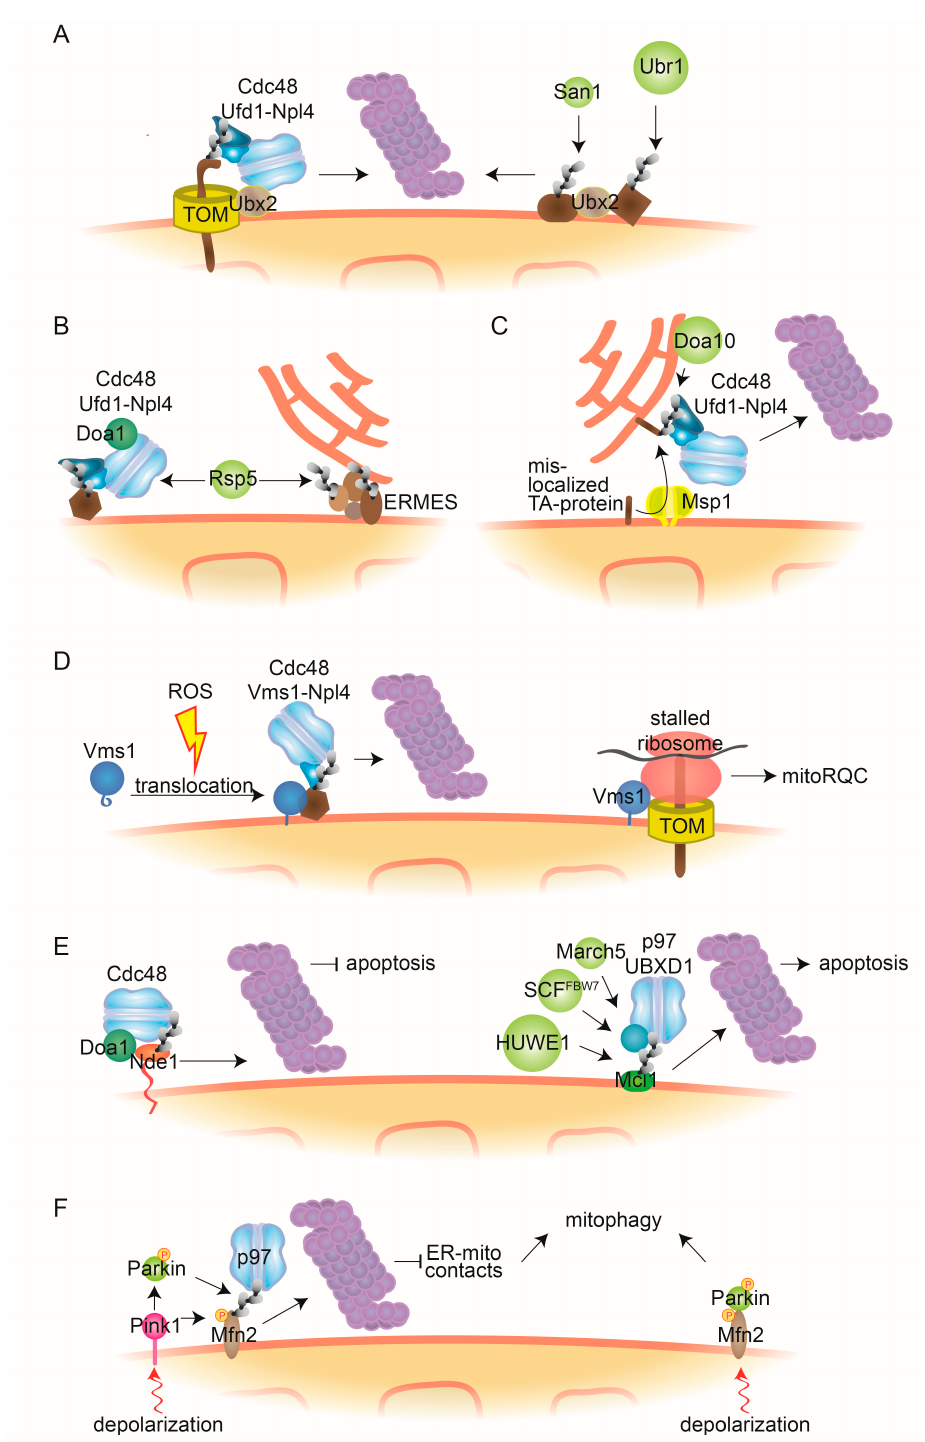
Figure 3. Cdc48-dependent MAD and mitochondrial quality control mechanisms. ( A ) Ubx2-dependent MAD. The Cdc48-cofactor Ubx2 partially localizes to the OMM where it facilitates the degradation of ubiquitylated mitochondrial proteins bound to the TOM channel, dependent on the Cdc48-Ufd1-Npl4 complex. Further, Ubx2 recognizes mitochondrial substrates that are ubiquitylated by the quality control E3 ligases Ubr1 and San1. ( B ) Doa1-dependent MAD. The Cdc48-Ufd1-Npl4 complex, together with the cofactor Doa1 / Ufd3, assists proteasomal degradation of OMM proteins ubiquitylated by E3 ligase Rsp5. Additionally, Rsp5 can ubiquitylate the ERMES components Mdm12 and Mdm34. ( C )